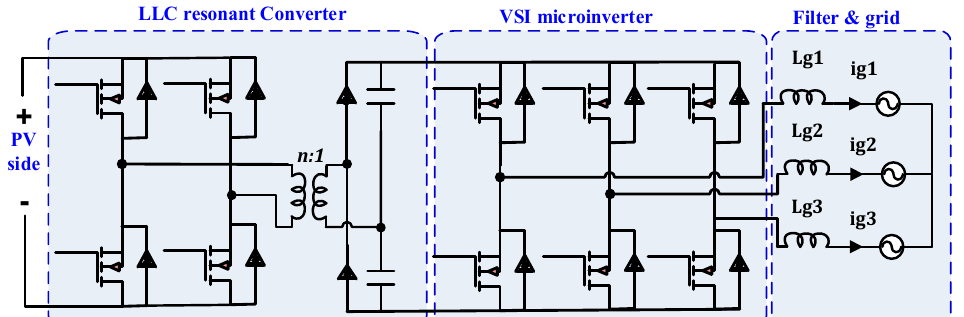
Figure 18. Two-stage three-phase microinverter proposed by Chen and co-workers [105]. Table 4. Performance voltage stress for selected topologies of Z-source microinverters [99–104]. Topology Switch stress Capacitor stress Fig./Ref.